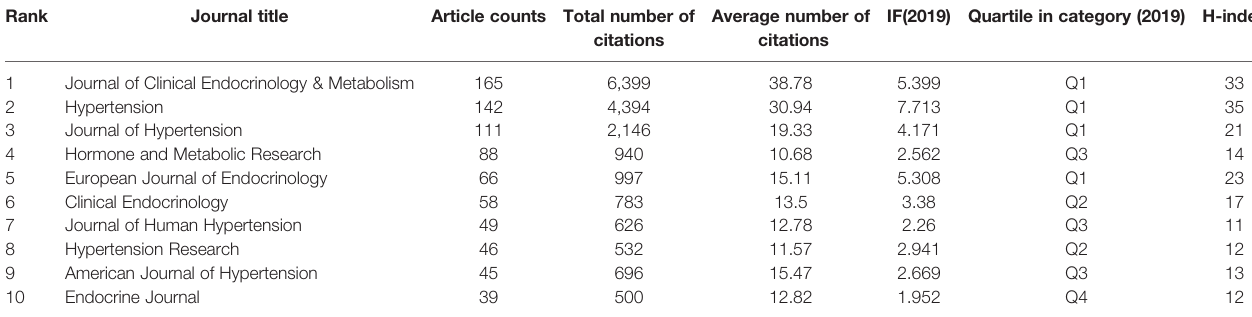
TABLE 3 | The top 10 most active journals that published articles in PA